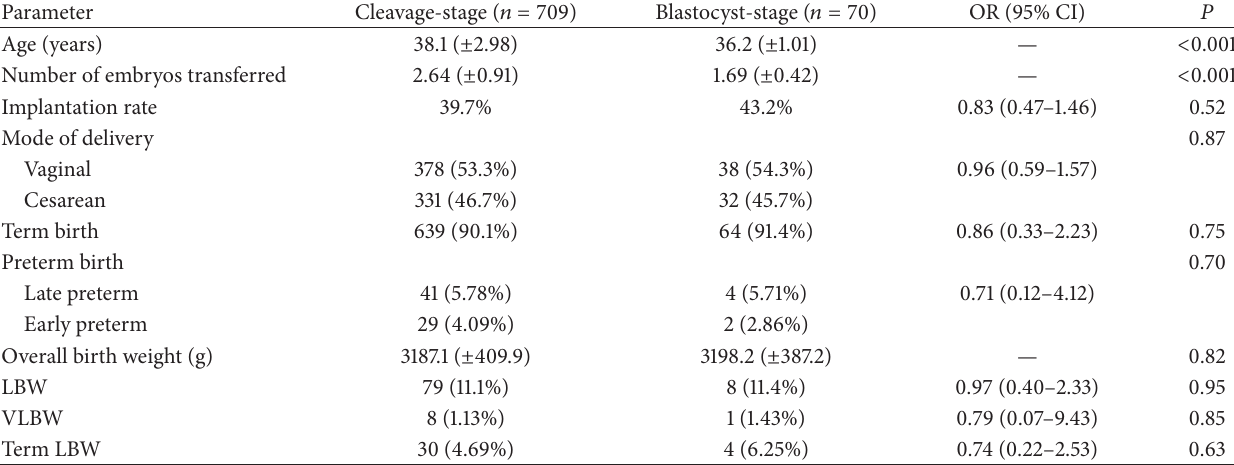
Table 3: Comparison of perinatal outcomes in patients undergoing cleavage-stage ETs ( 𝑛 = 709 ) or blastocyst-stage ETs ( 𝑛 = 70 ) with early VT.